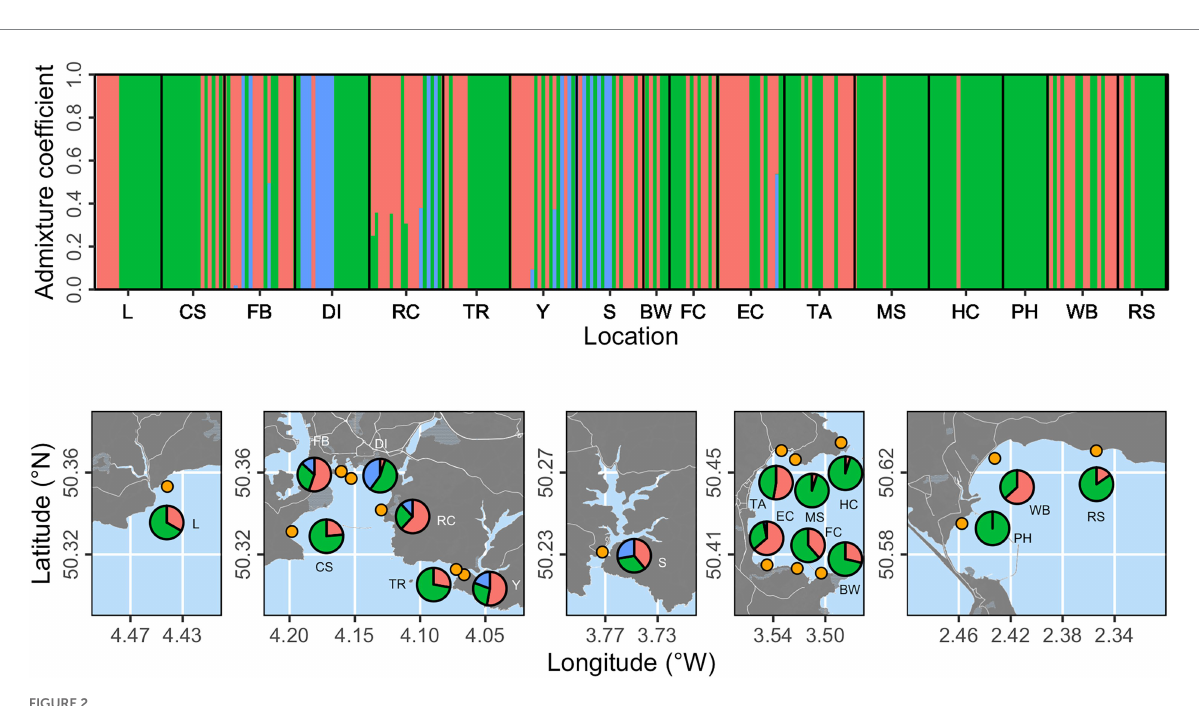
between alleles of each leaf sample in this diploid species.